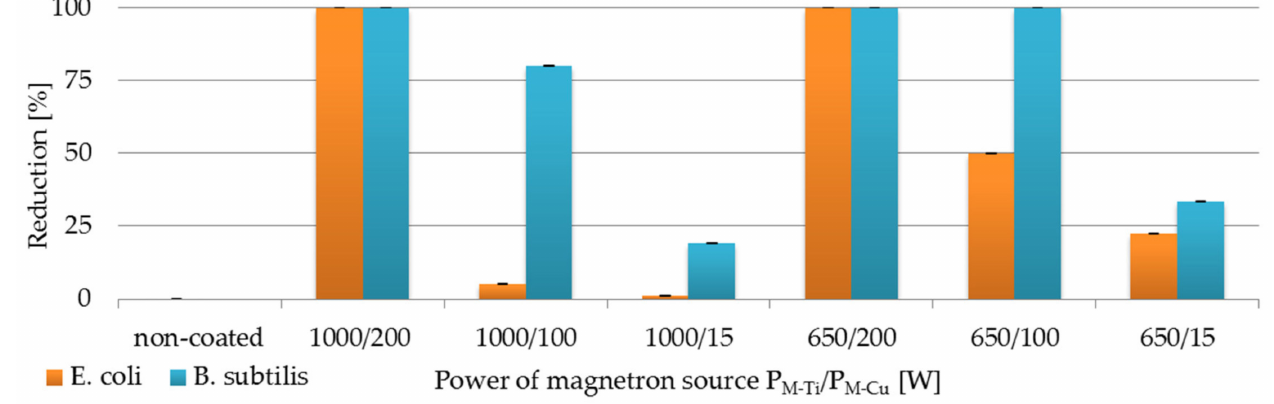
Figure 6. Reduction (%) in viability of E.coli and B. subtilis on the non-coated membrane and membranes covered with TiO 2 + CuO coatings deposited within 30 s at different magnetron powers (P M-Ti /P M-Cu ).